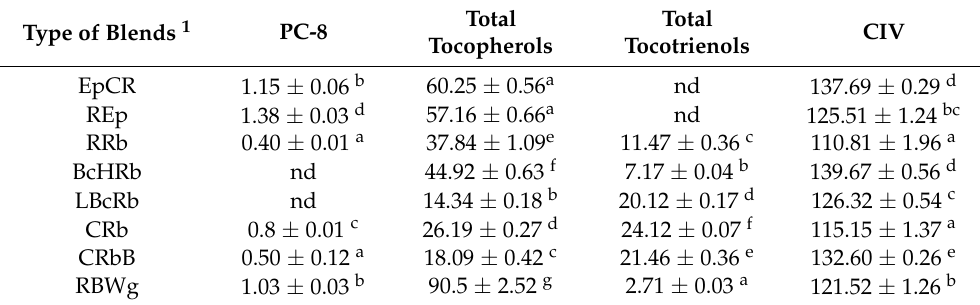
Figure 1. The share of main fatty acids of oil blends. SFA—saturated fatty acid, MUFA—monoun- saturated fatty acid, PUFA—polyunsaturated fatty acid, SD—standard deviation, SE—standard error. Identification of oil blends is shown in Table 1. Table 2. Content of tochochromanols [mg/100 g of oil] and Calculated Iodine Value (CIV) of oil